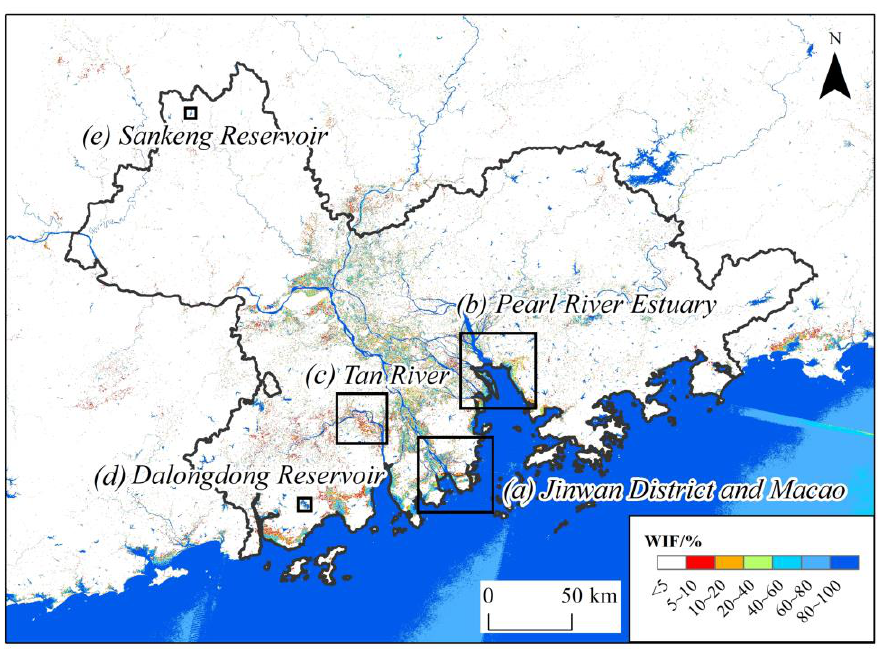
Figure 5. Spatial distribution of water inundation frequency from 1986 to 2020. ( a – e ) represent parts of Jinwan District and Macao, Pearl River estuary, Tan River, Dalongdong Reservoir and Sankeng Reservoir, respectively.